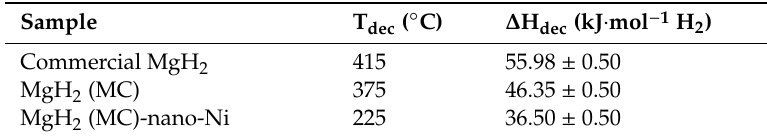
Table 2. Hydrogen desorption reaction enthalpy ( ∆ H dec ) of commercial bulk MgH 2 ,